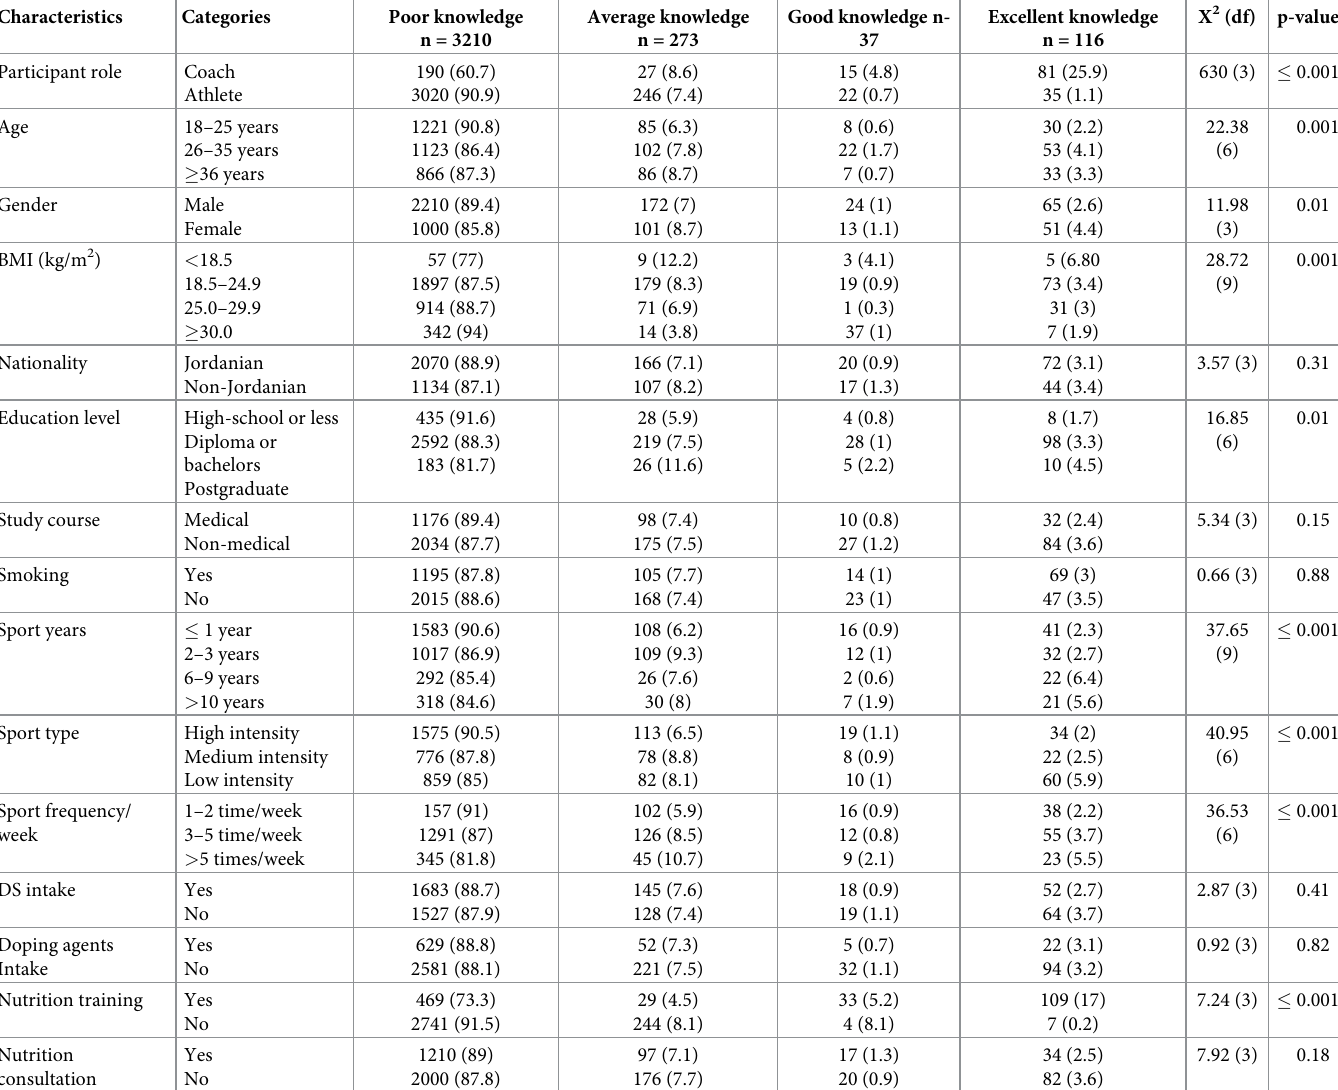
Table 3. Univariate analysis of relationship between participant sociodemographic, lifestyle characteristics and knowledge categories achieved on the Abridged Nutrition Knowledge Questionnaire (ANSKQ).